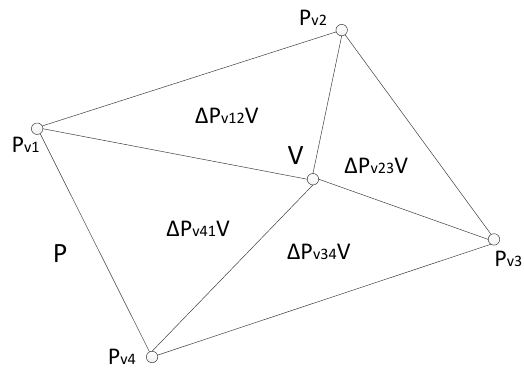
Fig. 2 Sketch map for image-vertex topology identification